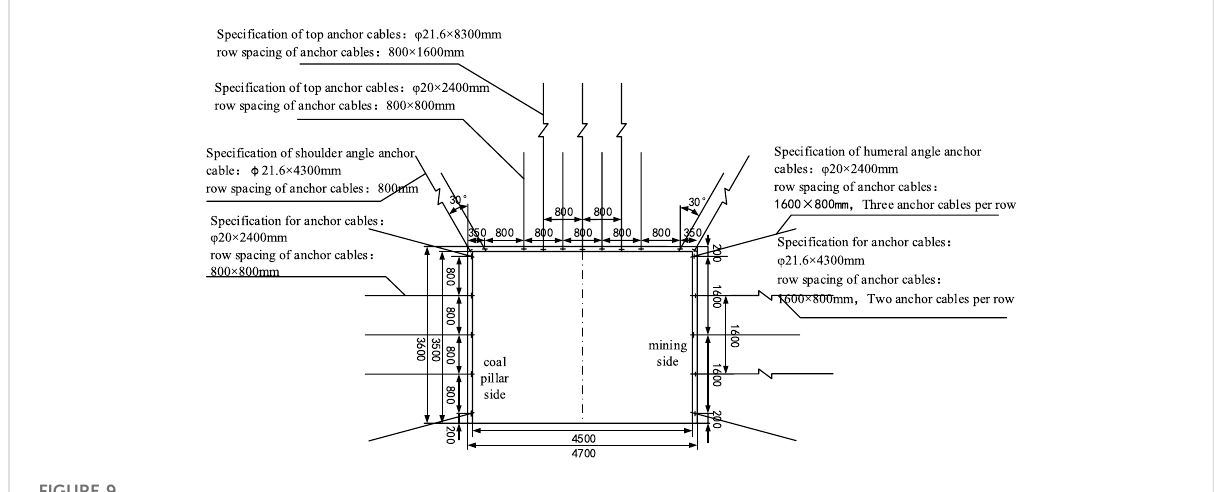
FIGURE 9 Schematic diagram of the roadway support